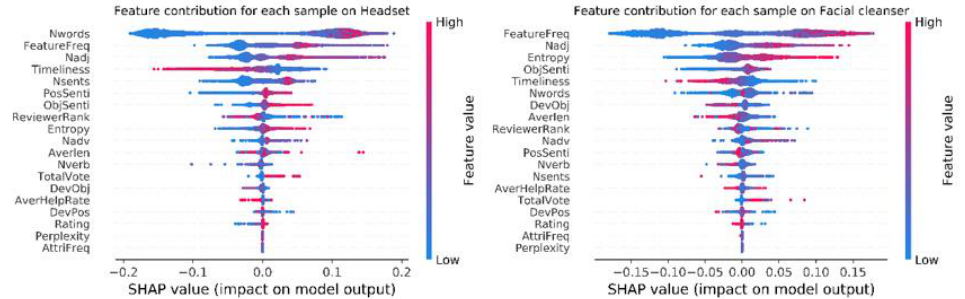
Figure 4. Comparison of individual feature contributions. (Source of data: https://www.amazon.cn).